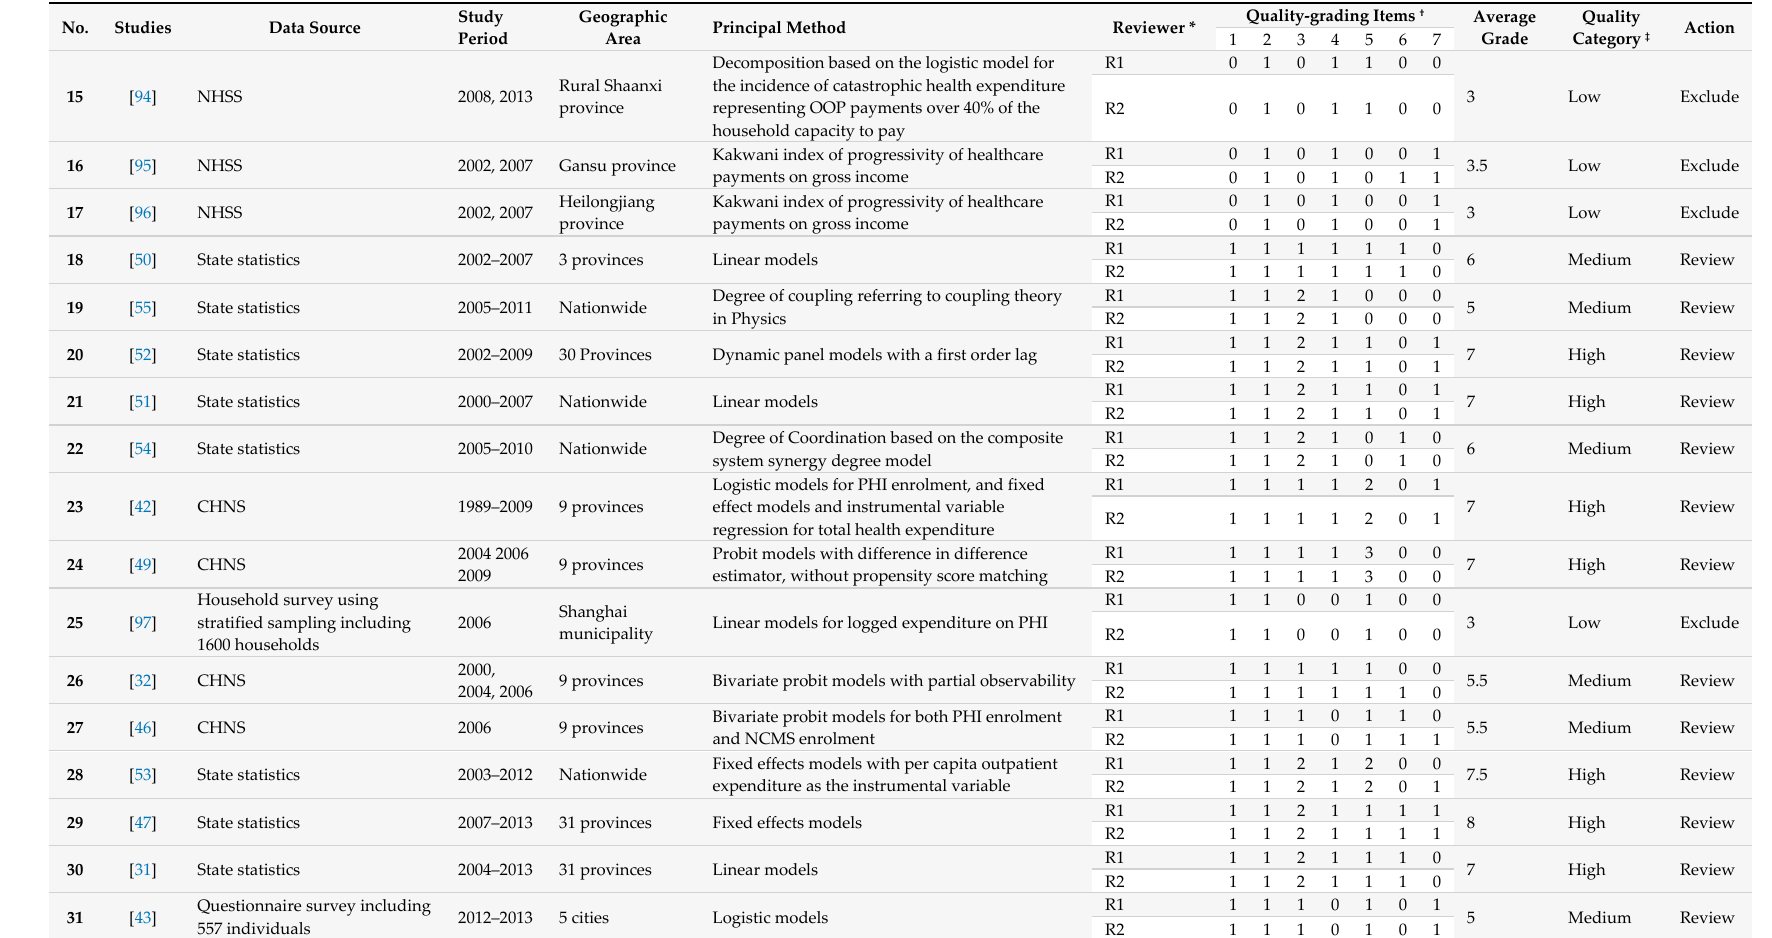
Table A1. Cont. Int. J. Environ. Res. Public Health 2020 , 17 , x FOR PEER REVIEW 3 of